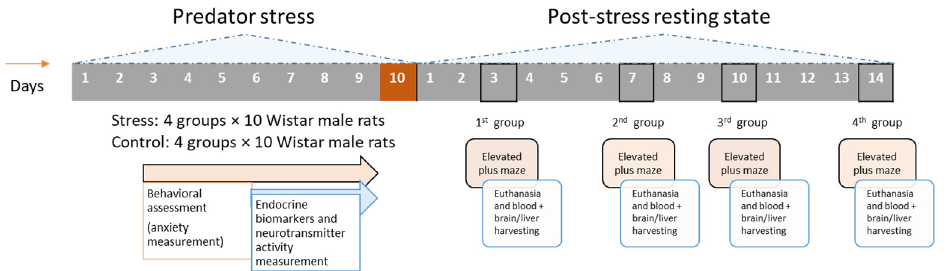
Figure 9. Timeline of experimental procedures. All experimental groups received 10 days of PSS, and all control groups received 10 days of sham PSS stress. Experimental and control groups were tested for behavior and then killed for biochemical assays of blood, brain, and liver at 3, 7, 10, and 14 days after PSS or sham PSS, respectively.